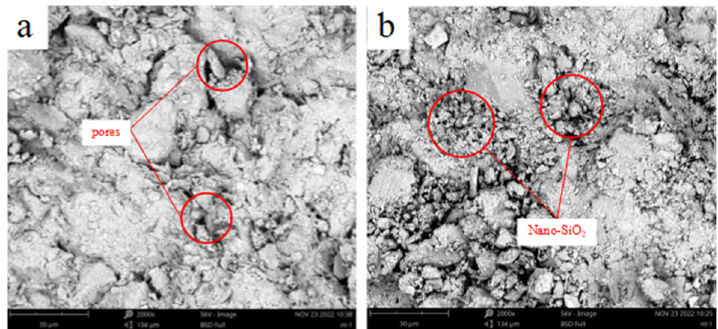
Figure 12. SEM micrographs of the ( a ) clayey soil; ( b ) 2% nano-SiO 2 -reinforced clayey soil.